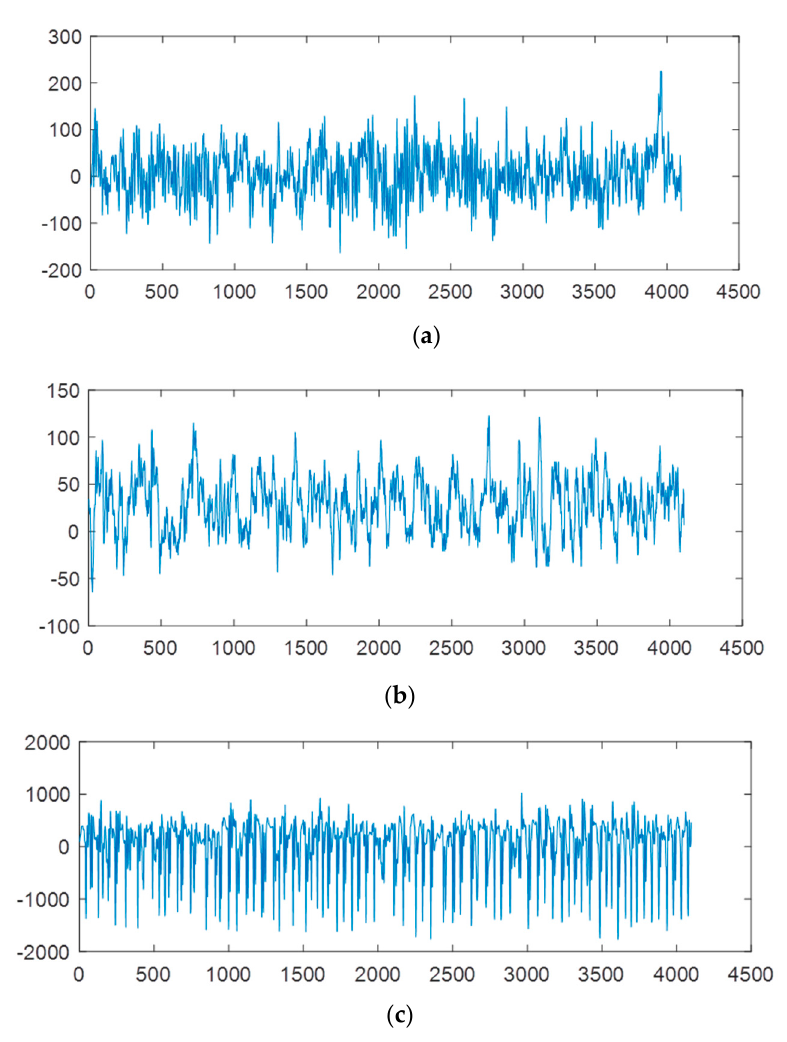
Figure 2. Normal ( a ), preictal ( b ) and seizure ( c ) signals.